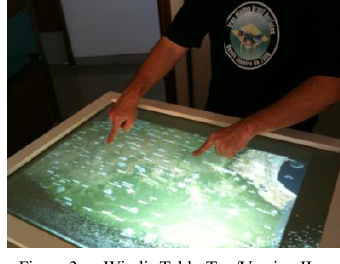
Figure 3. Windis Table-Top/Version II-a.